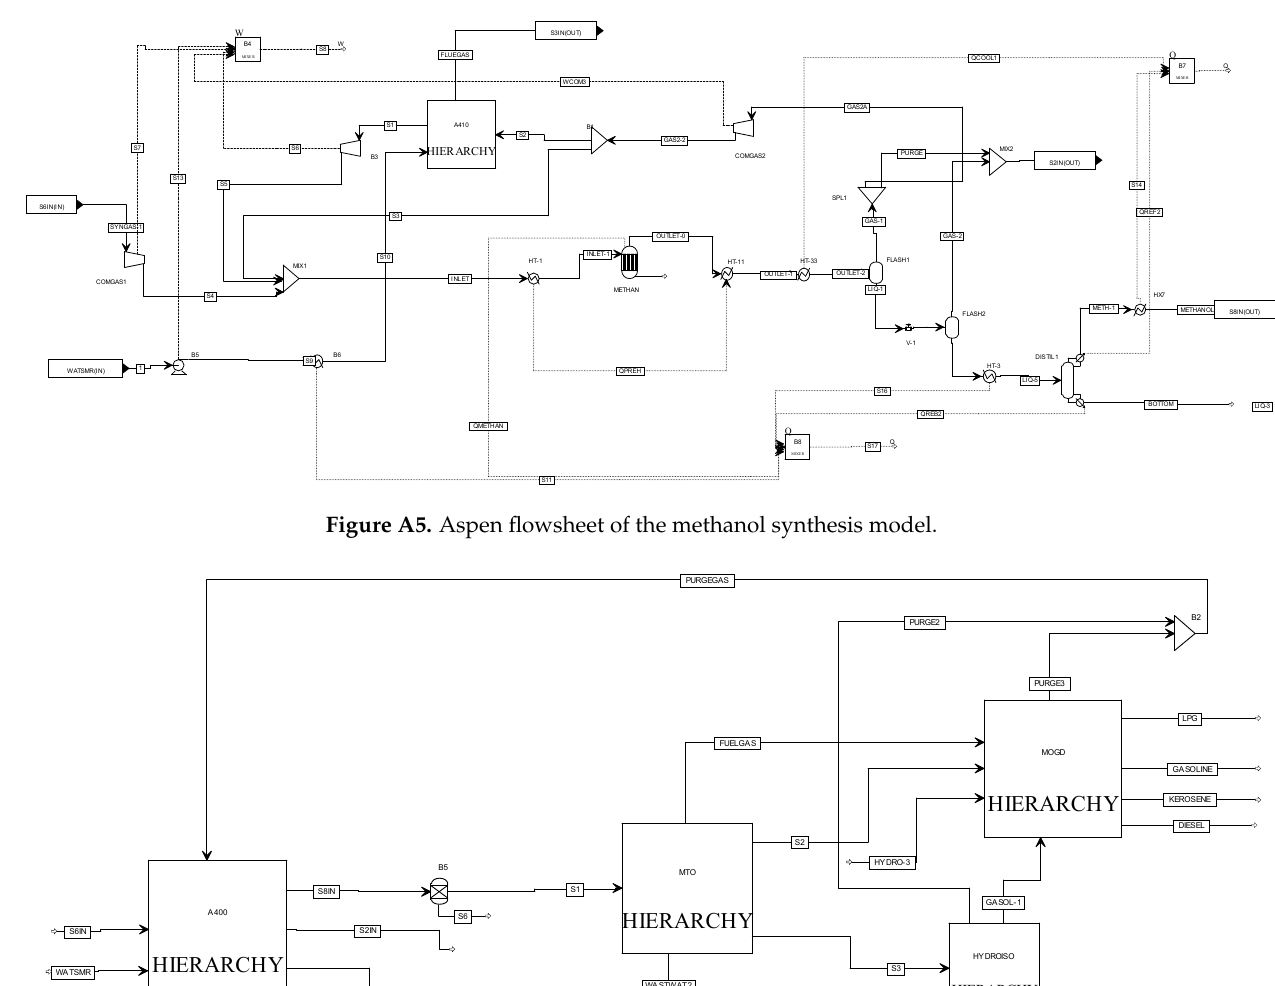
Figure A4. Aspen flowsheet of the Rectisol model.